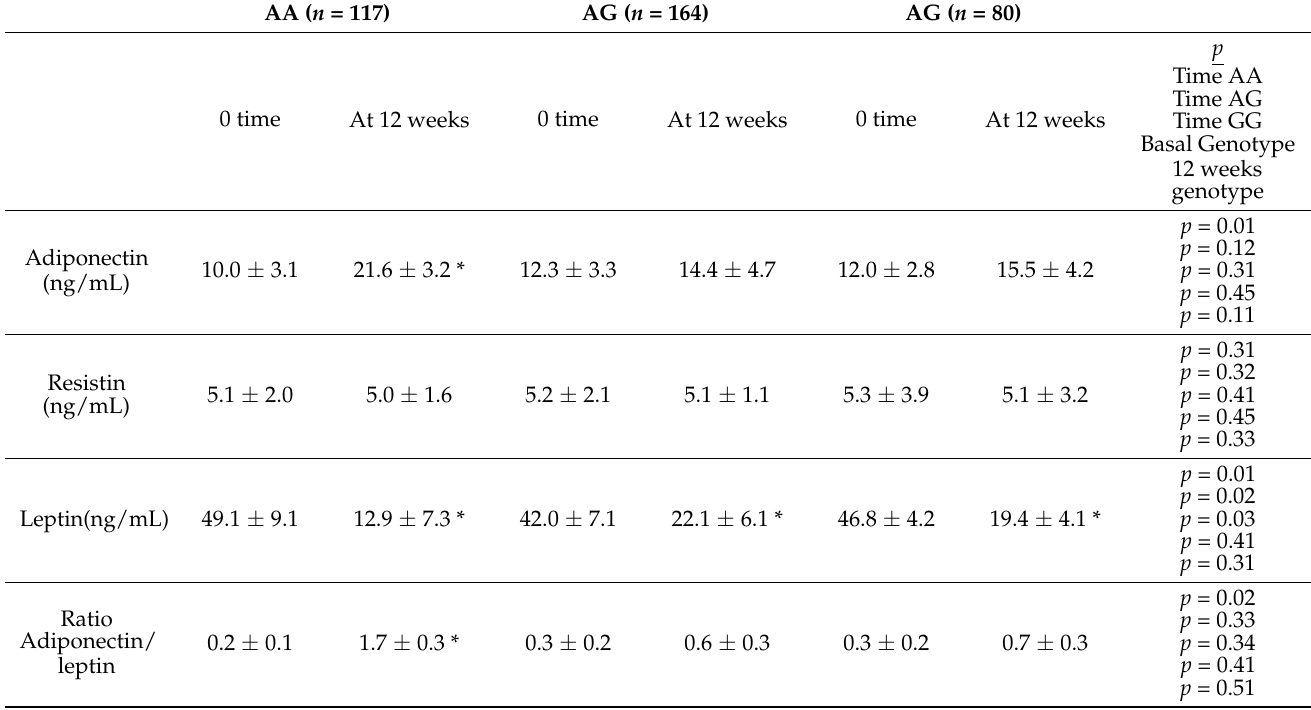
Table 3. Serum levels of adipocytokines (mean ±